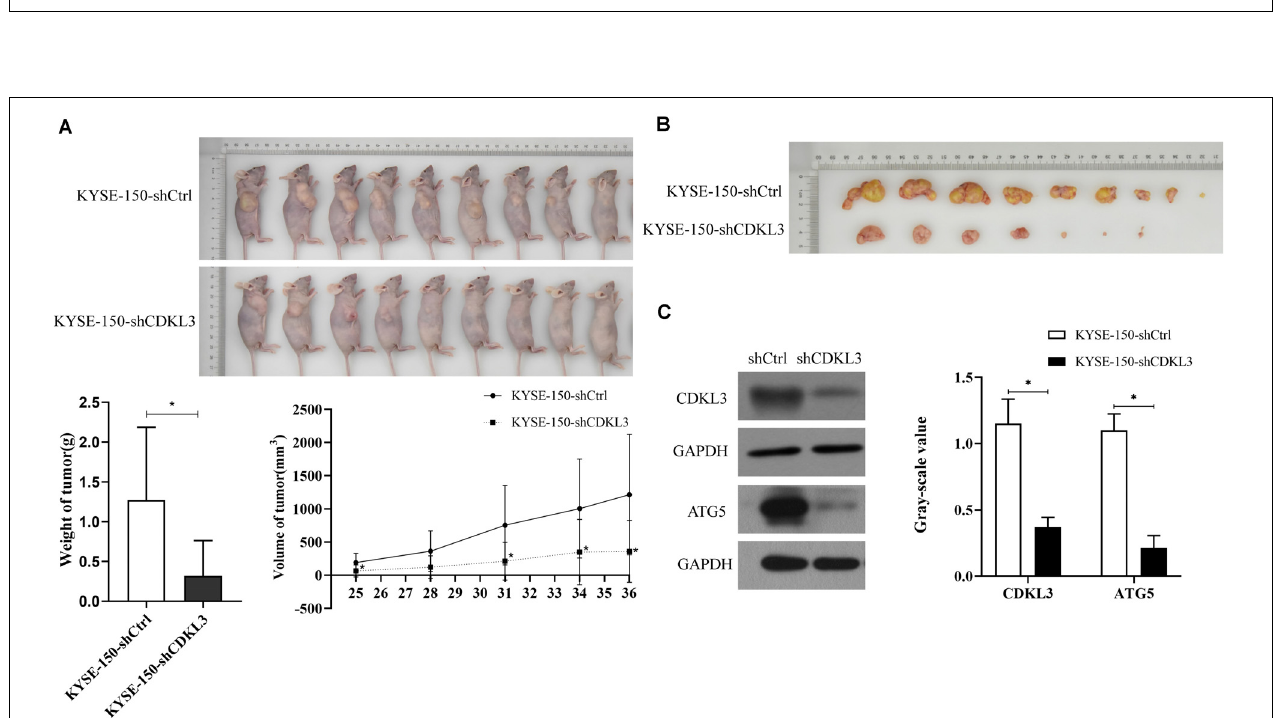
FIGURE 4 | CDKL3 knockdown retarded tumor growth in vivo . (A) KYSE-150-shCDKL3 cells generated smaller tumors in nude mice compared to the KYSE-150-shCtrl cells, * P < 0.05. (B) KYSE-150-shCDKL3 cells formed lighter tumors compared to the KYSE-150-shCtrl cells, * P < 0.05. (C) Western blotting analysis of the presence of CDKL3 and ATG5 proteins from the harvested tumors as described for (B) , * P < 0.05. Data were represented as mean ± SD.